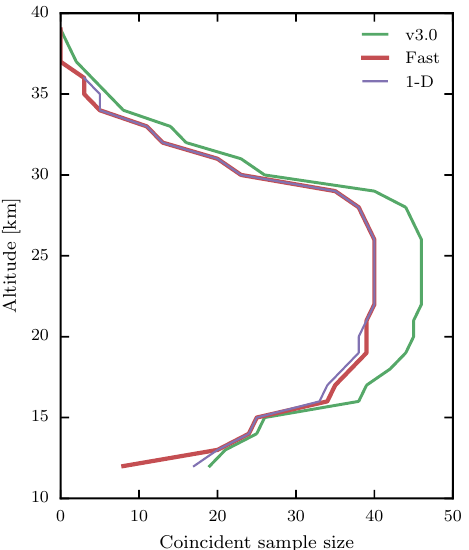
Figure 5. Relative standard error of coincident NO 2 profiles. Note that OSIRIS profiles have been scaled to various local times of the balloon measurements, which adds random error to the OSIRIS pro- files due to random variations between the photochemical model atmosphere and the true